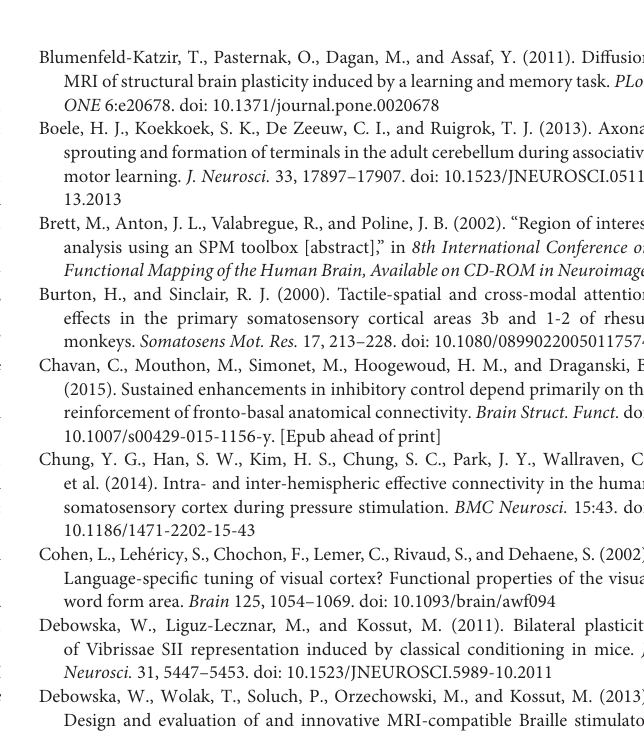
Figure S1 | Braille training—overall fMRI results. Statistical parametric maps of the Braille vs. movement (A) and Braille vs. rectangles (B) contrasts, separately for before and after the Braille training. Results are presented on a glass-brain in MNI space (view from the top, back, and left of the brain), p < 0.05,